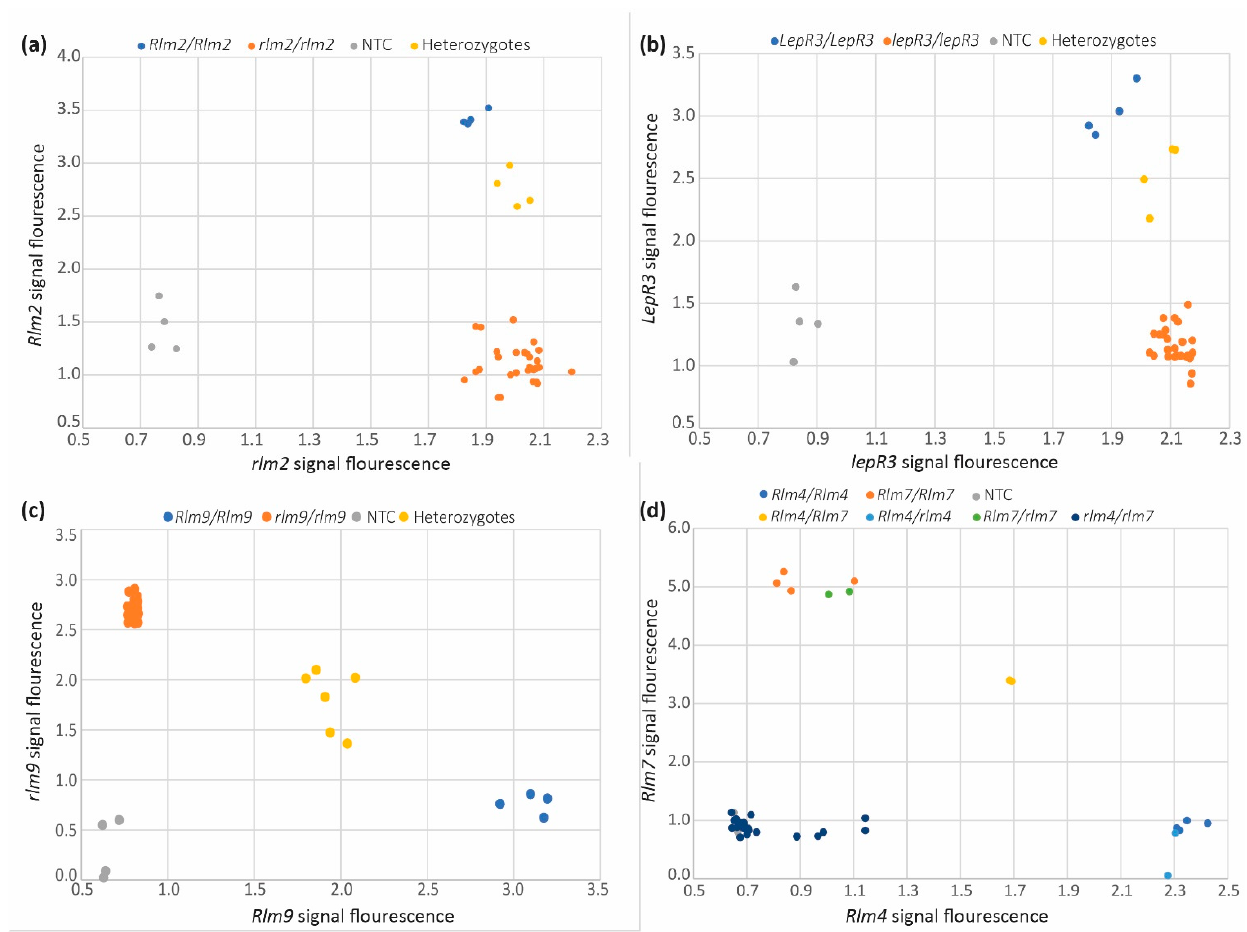
Figure 3. Cluster plot diagrams of Kompetitive Allele-Specific PCR (KASP) assays for Rlm2 ( a ), LepR3 ( b ), Rlm9 ( c ) and Rlm4 and Rlm7 ( d ). Each data point represents the fluorescence signal of a single DNA sample. DNA samples from 16 B. npaus. ( a – c ) The KASP markers for Rlm2 , LepR3 and Rlm9 allow heterozygotes to be distinguished from the homozygote resistant and susceptible lines. ( d ) However, for the KASP marker for Rlm4 and Rlm7 , only Rlm4 / Rlm7 heterozygotes can be distinguished from the homozygote resistant and susceptible lines as the primer binds within the insertion that is specific to the Rlm4 and Rlm7 alleles, and therefore susceptible alleles do not amplify. Two replicates are included for all samples. NTC = no template control.